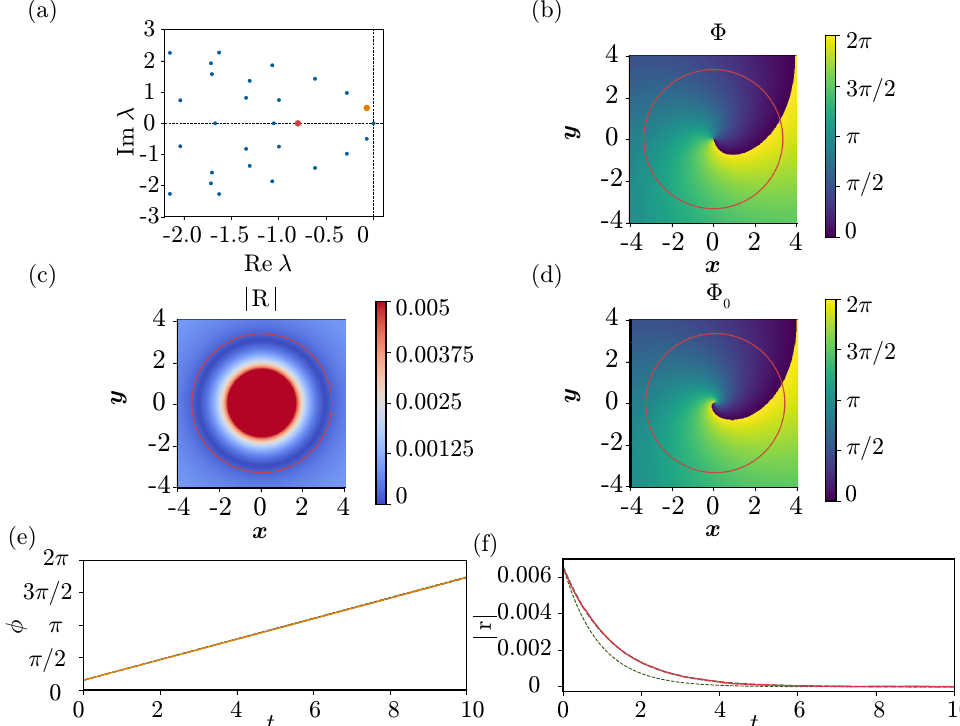
Figure 4. Phase and amplitude functions of a quantum Stuart–Landau model with a quantum Kerr effect in the semiclassical regime. ( a ) Eigenvalues of L + near the imaginary axis. Orange and red X dots represent eigenvalues Λ 1 and Λ 2 , respectively. ( b ) Phase function Φ . ( c ) Amplitude function | R | . ( d ) Phase function Φ 0 of the deterministic system. ( e ) Evolution of averaged phase φ . ( f ) Evolution of averaged amplitude | r | . In ( b , d ), ( x , p ) = ( 2.5,0 ) is chosen as the phase origin. In ( e , f ), averaged results over 10,000 trajectories (orange and red thin lines) and analytical solutions for the semiclassical case (blue-dotted lines) and results for the deterministic case (green-dotted lines) are shown. Figure 4e,f show the time evolution of the values of the phase and amplitude averaged over 10,000 trajectories obtained by direct numerical simulations of the semiclassical Equation (45) from the initial point ( x 0 , y 0 ) = ( 2.5, 0 ) . They show good agreement with the analytical solutions φ = ω 1 t + φ 0 and | r | = | r 0 | exp ( Λ 2 t ) , where the values of the fundamental frequency ω 1 = 0.496 and the decay rate Λ 2 = − 0.798 are